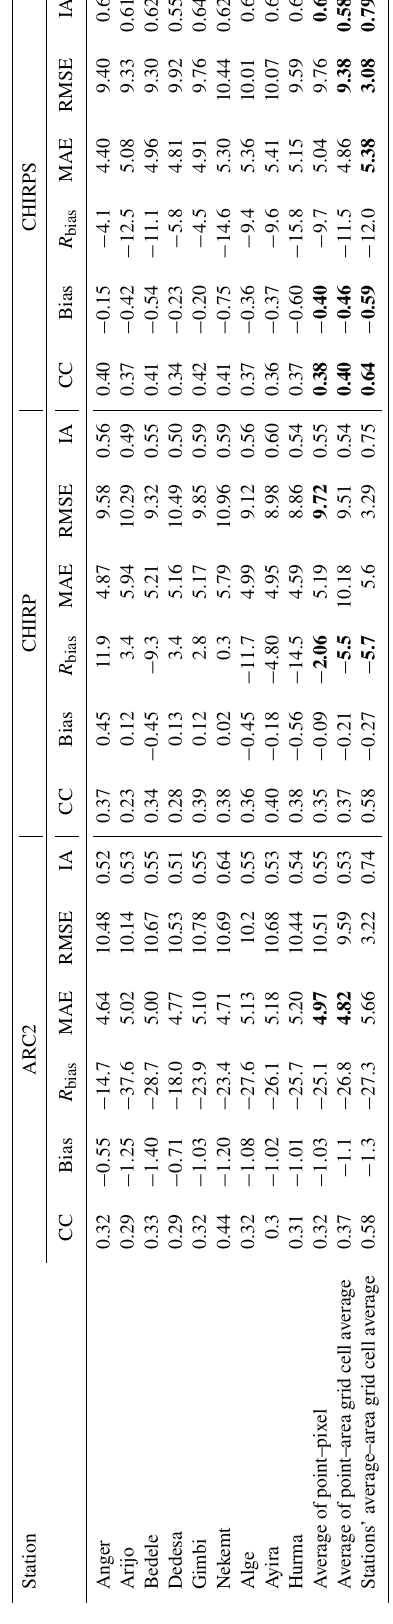
( − 15 . 1 % deviation) and average daily rainfall ( − 23 . 8 %